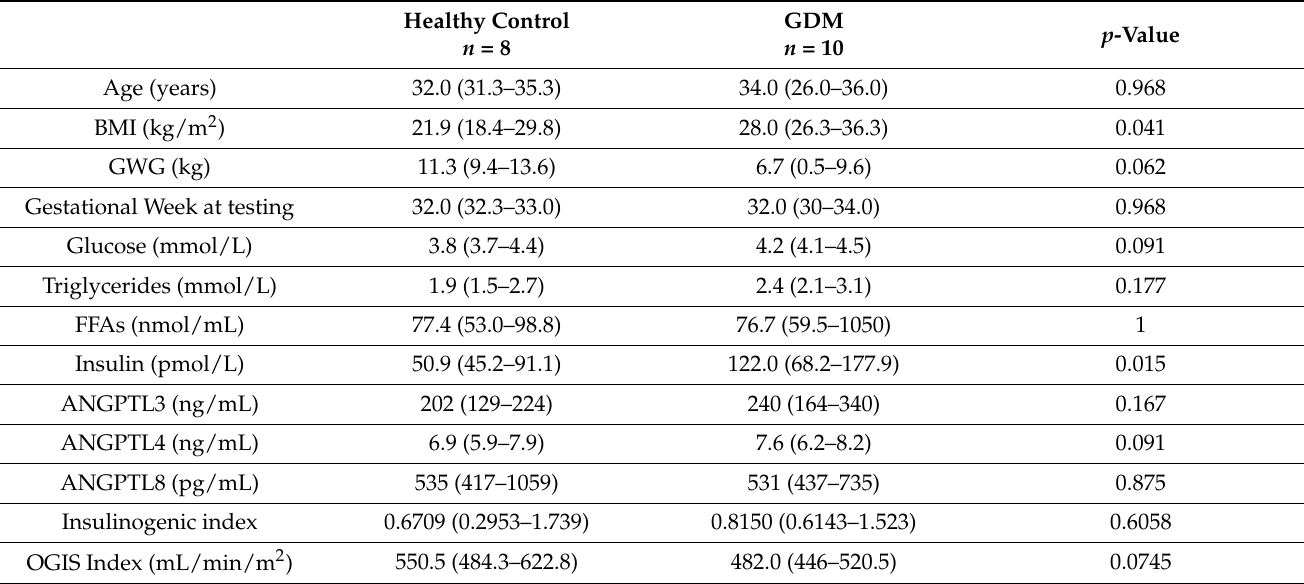
Table 1. Characteristics of pregnant women included in the meal test